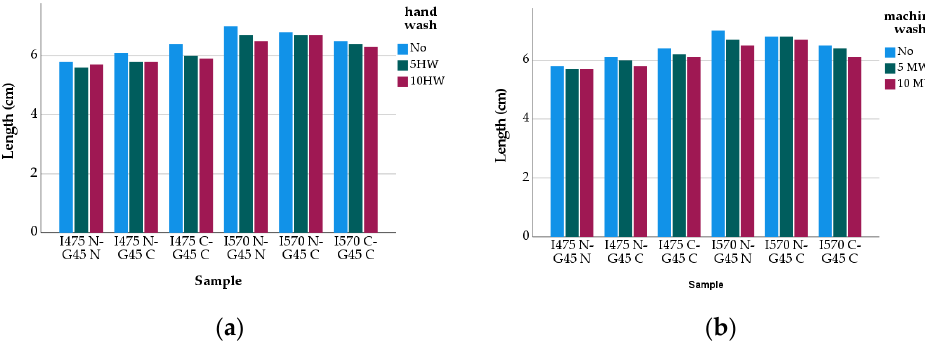
Figure 4. Length Change: ( a ) Hand-wash vs. ( b ) Machine-wash.